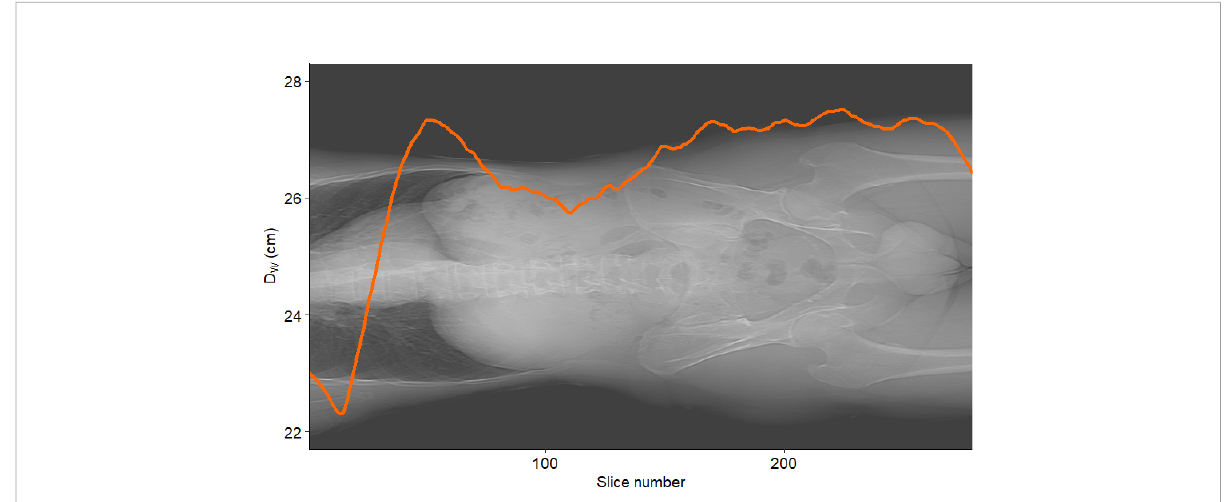
FIGURE 8 Example of D W vs. slice number for a sample patient. The curve represents the water-equivalent diameter D W computed for each